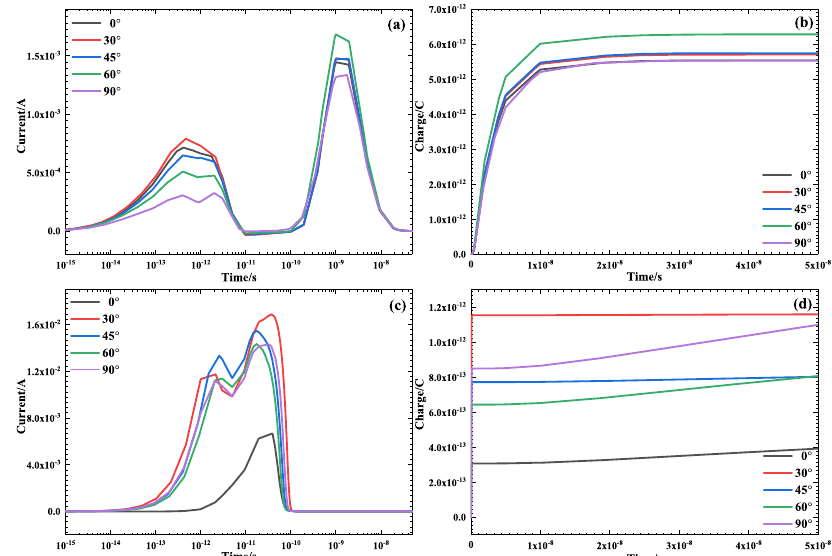
Figure 7. The current and collected charge change in the collector with time as heavy ions irradiate the center of collector ( a , b ) and substrate ( c , d ) of the SiGe